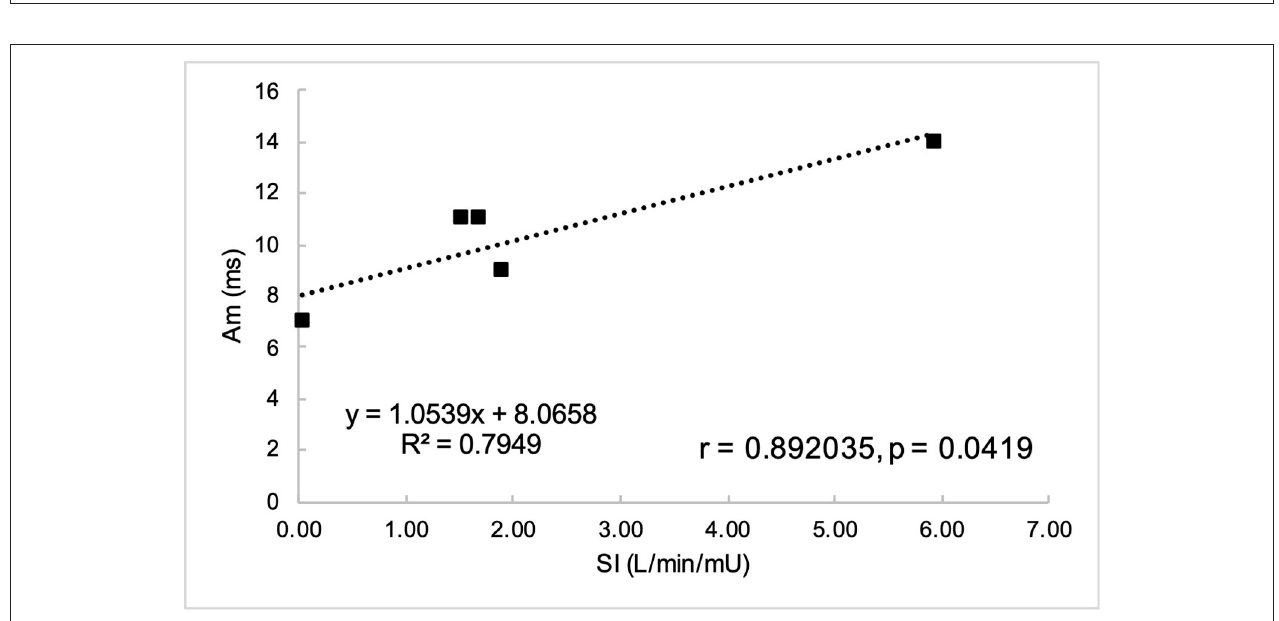
FIGURE 2 | Peak myocardial velocity during active atrial contraction in late diastole (A m ) was positively correlated with insulin sensitivity (S I